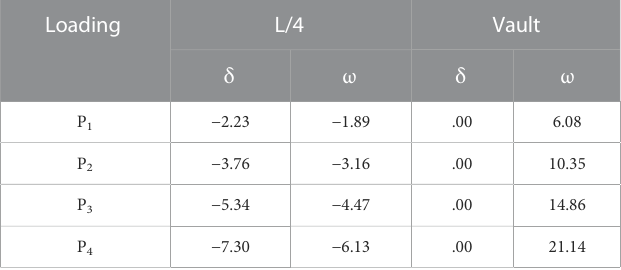
TABLE 9 A-1 arch P 1 ~P 4 measured displacement (unit: mm).